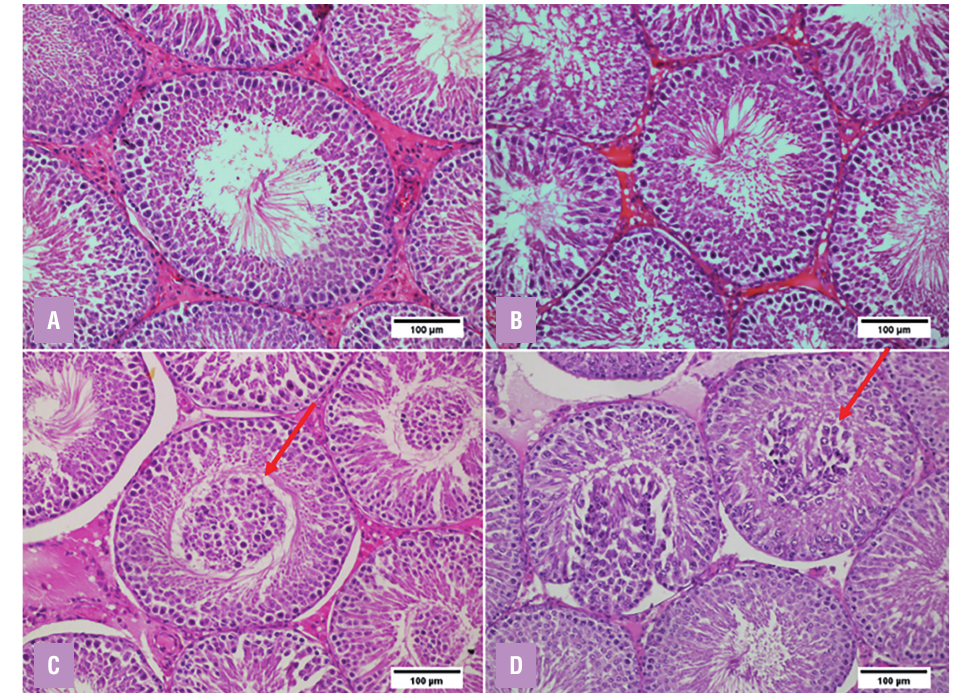
Figure 1 - Photomicrographs comparing normal and diabetic groups. The arrows point to the epithelial flaking resulting in the agglomeration of the cells in the tubular lumen in the diabetic